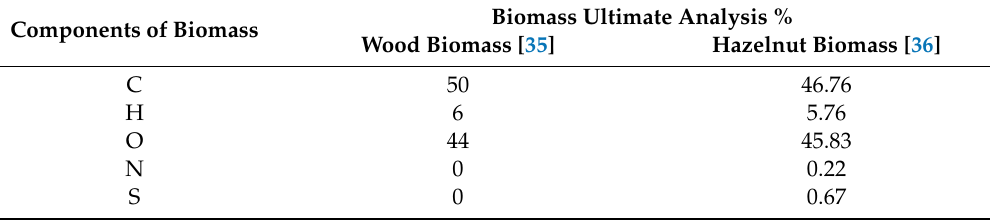
Table 4. Biomass compositions for the two validation cases in Tables 2 and 3.